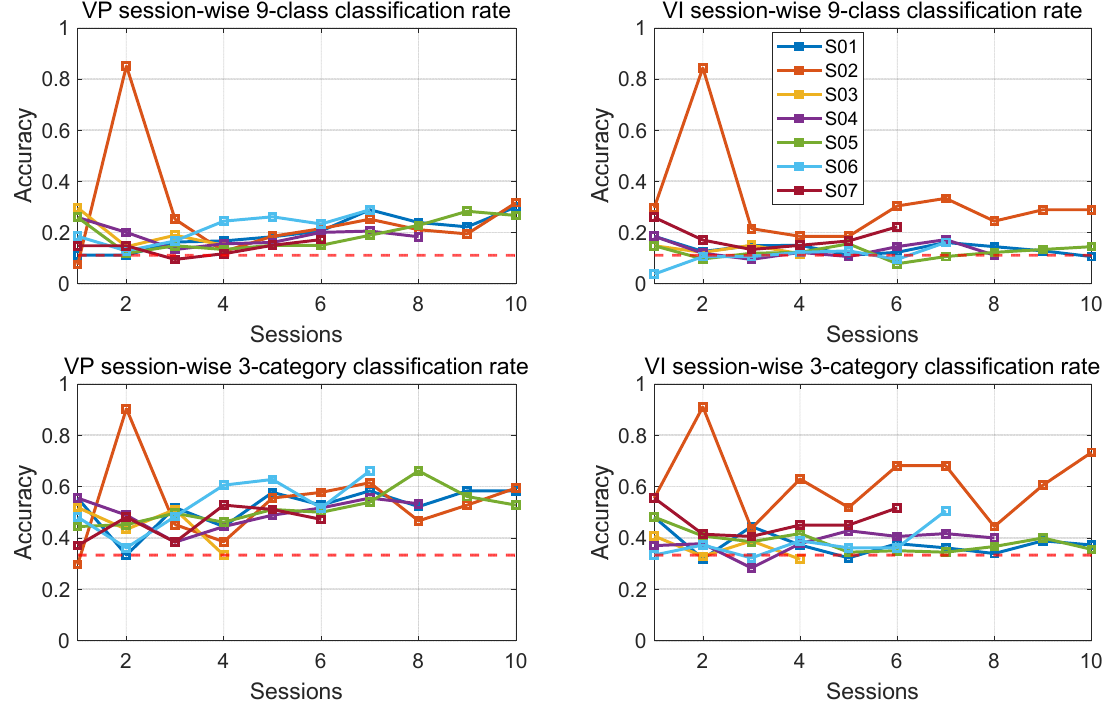
Figure 6. Classification accuracy over accumulated sessions.